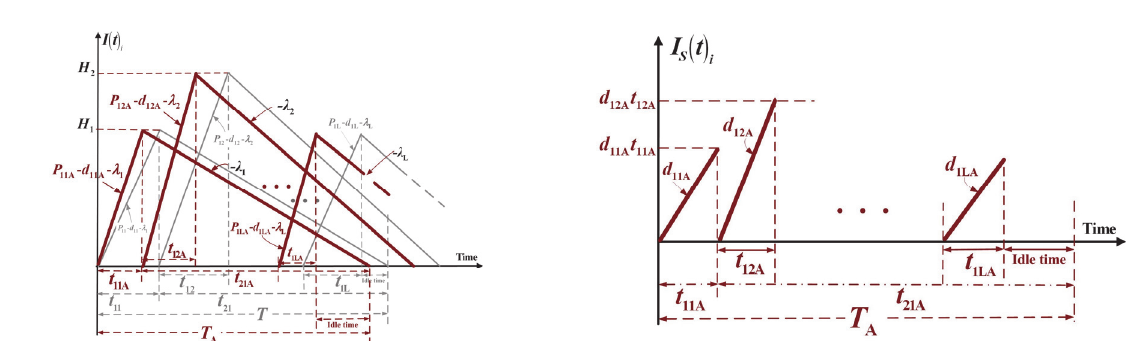
Fig. 2. Level of scrapped product i in the proposed FPR- based multiproduct inventory system with expedited rate and